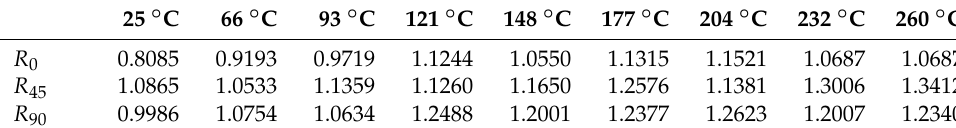
Table 2. Temperature dependent R-values adapted from Abedrabbo et al. [11].